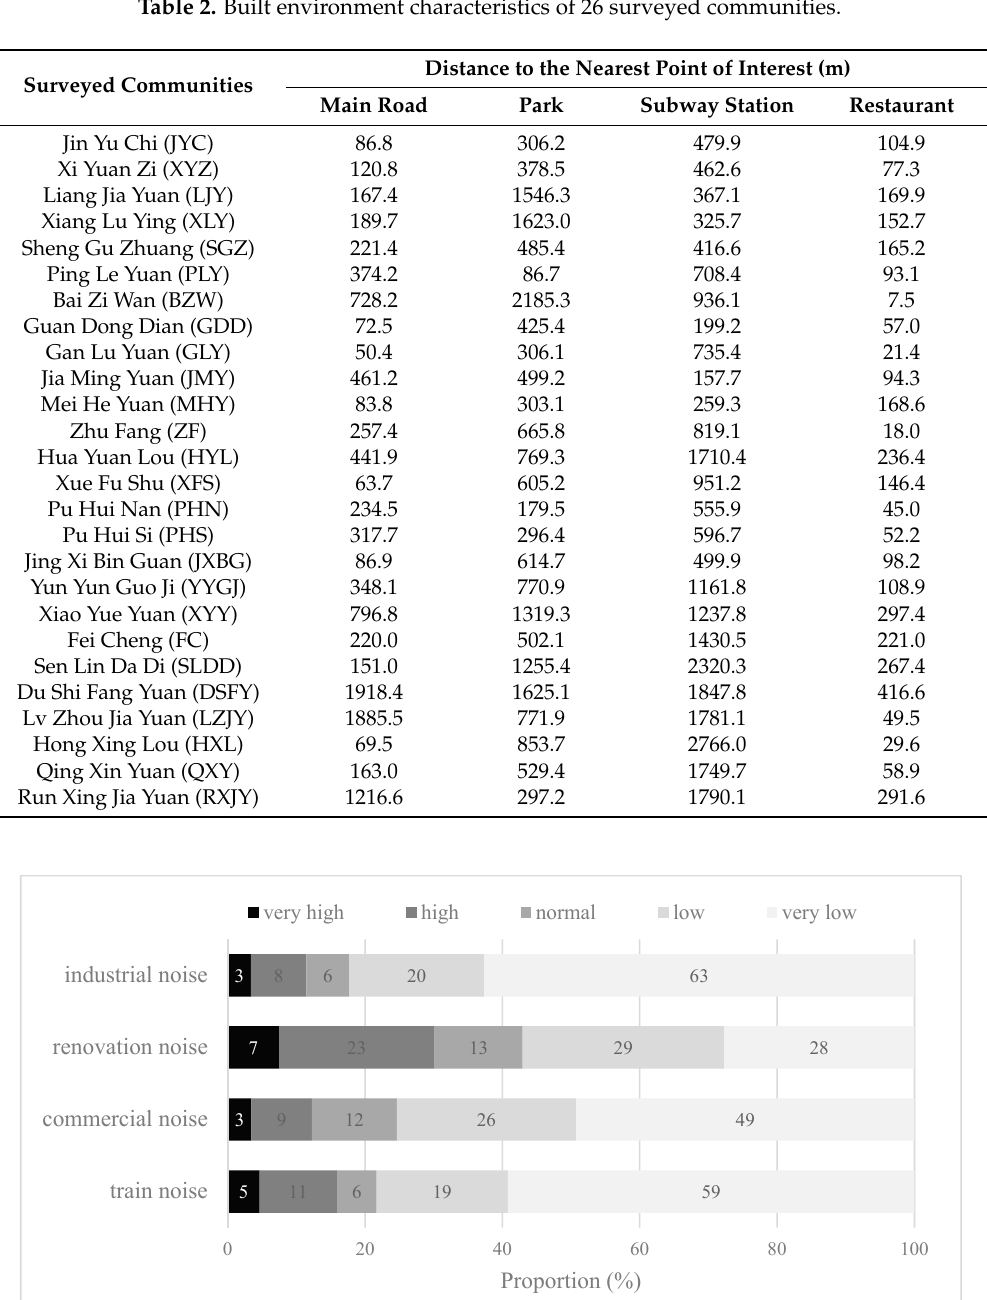
Table 2. Built environment characteristics of 26 surveyed communities.